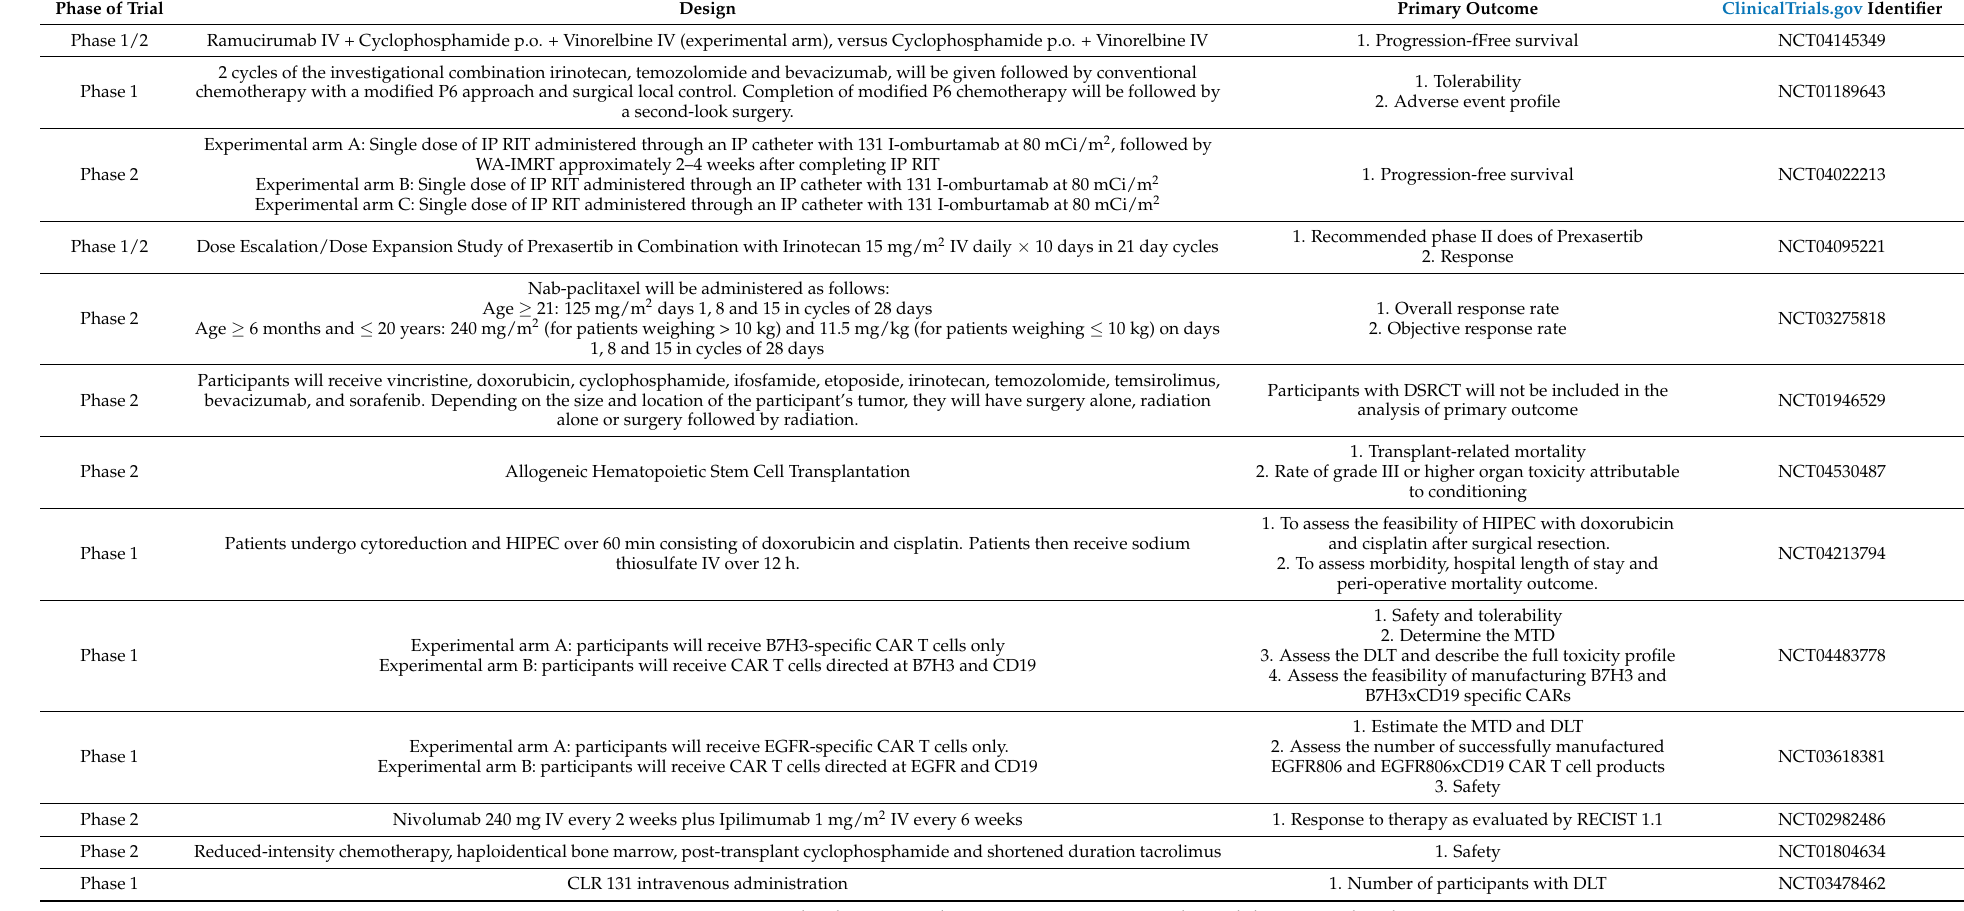
Table 4. Selected trials including desmoplastic small round cell tumor (DSRCT)